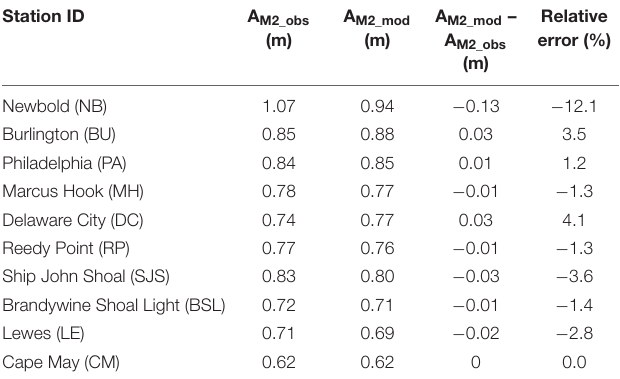
TABLE 3 | Comparison of observed and modeled M2 tidal amplitude in the